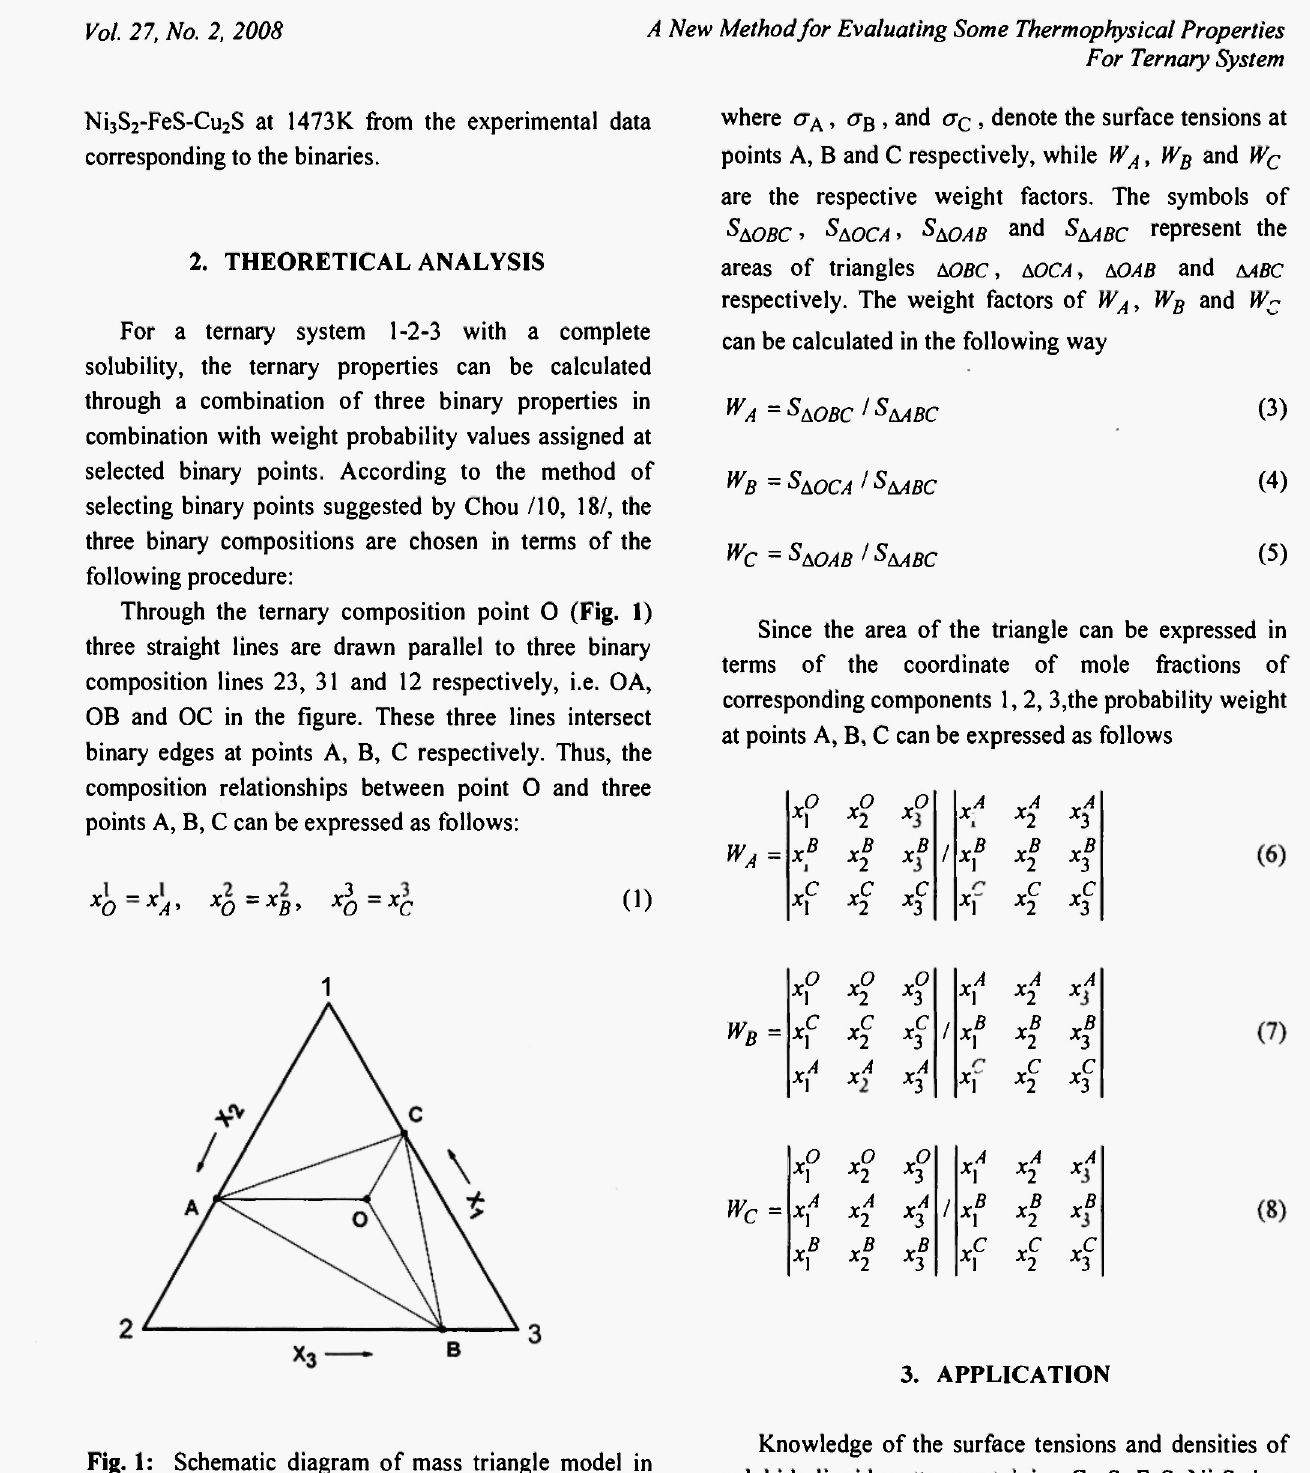
Fig. 1: Schematic diagram of mass triangle model in ternary